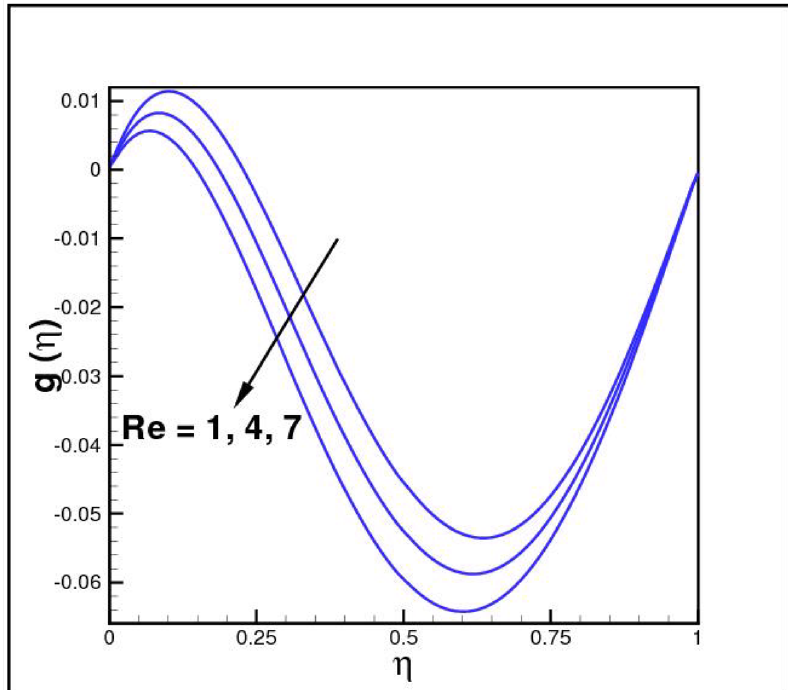
Figure 7. Impact of Re on g ( η ).